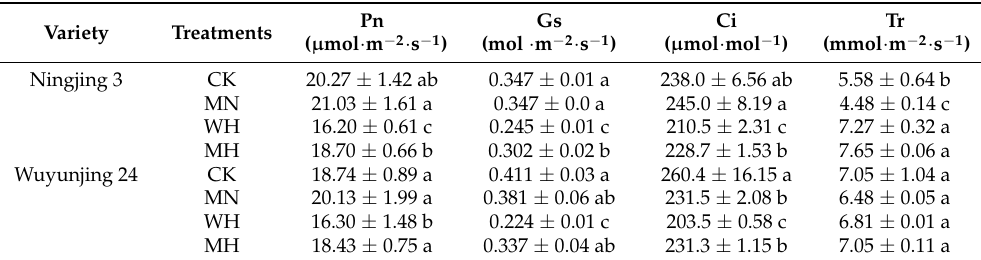
Table 1. Effects of exogenous MeJA on photosynthesis and chlorophyll fluorescence parameters under high temperatures.